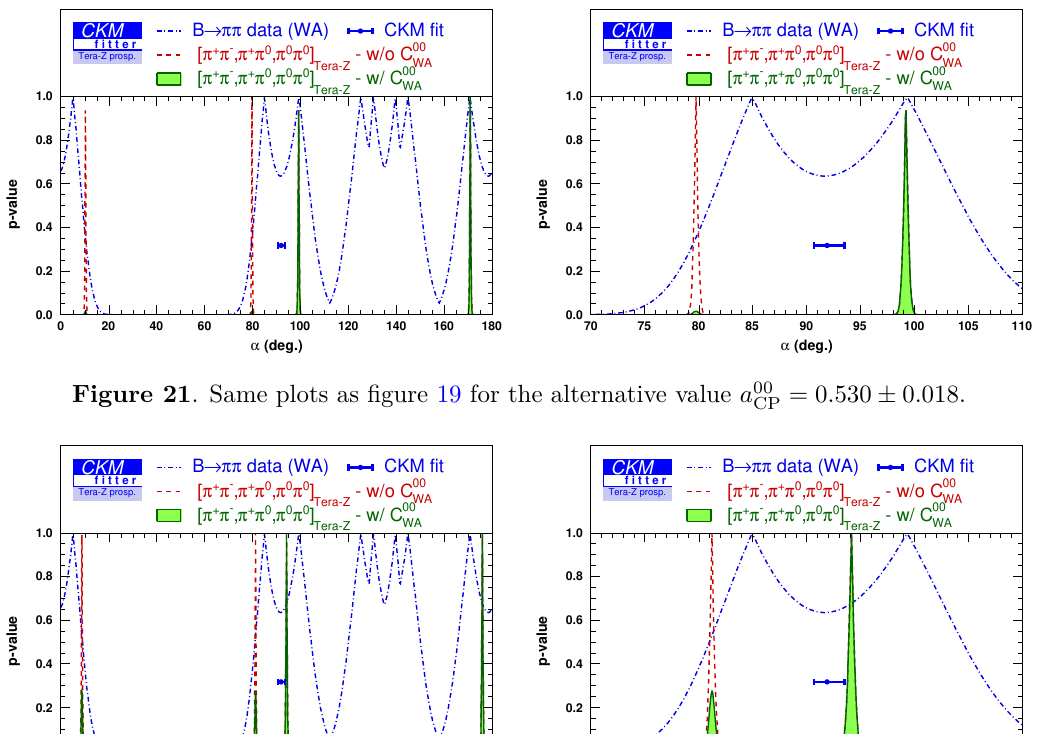
Figure 22 . Same plots as figure 19 for the alternative value a 00